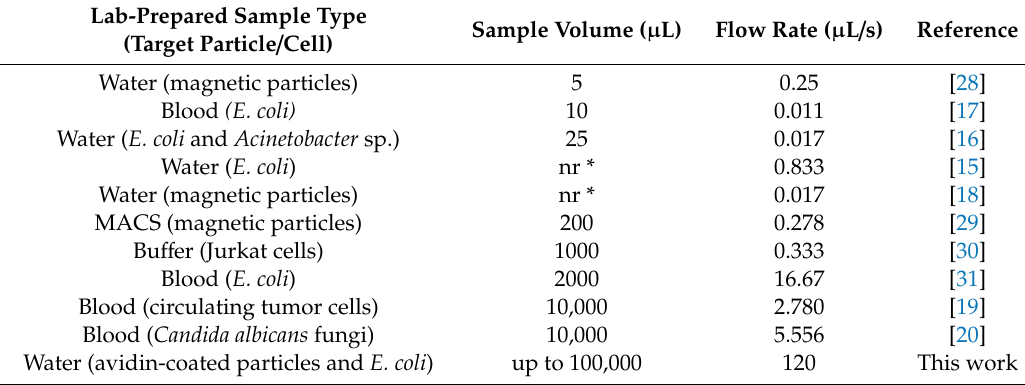
Table 1. Summary of microfluidic magnetic separation recent works.